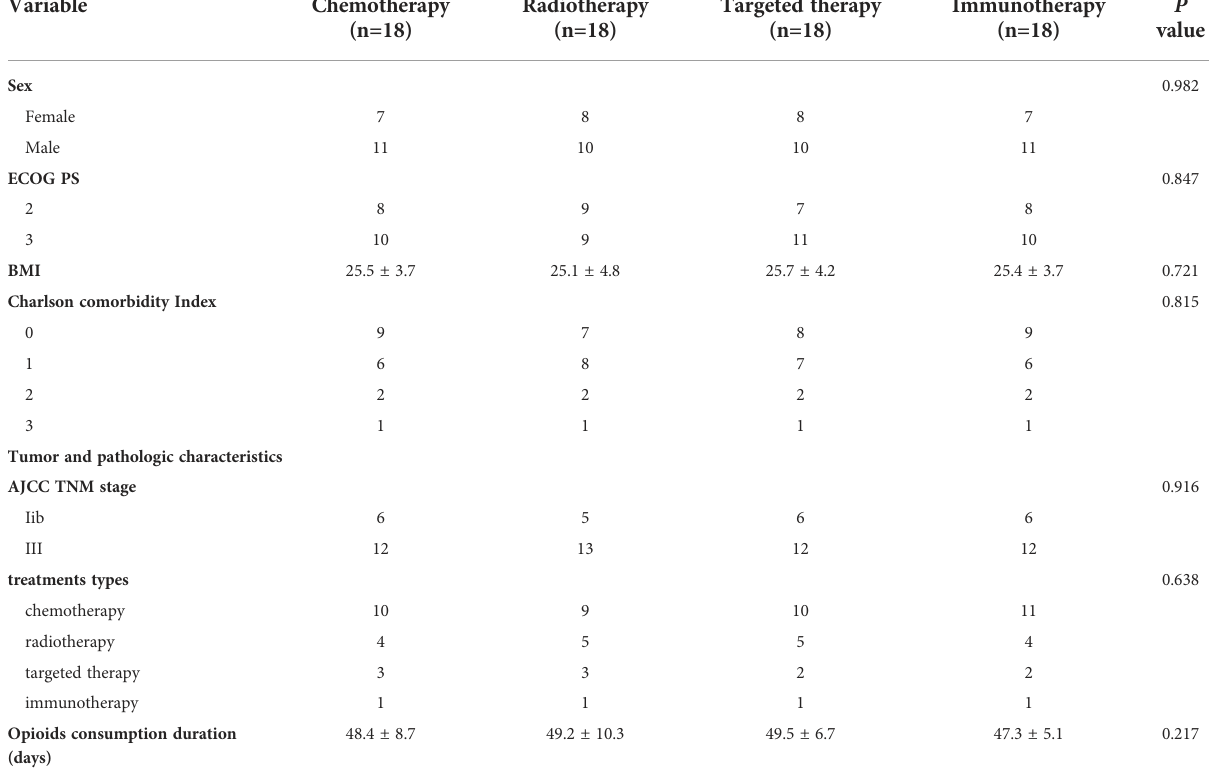
TABLE 2 Demographics and clinical characteristics of enrolled patients who received opioid treatment after PSM.